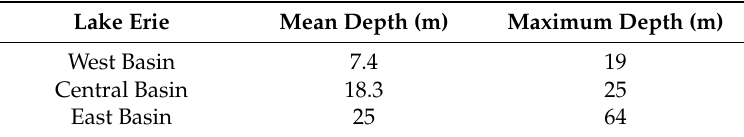
Figure 1. Location of Lake Erie and its boundary (Canada and US). In situ sampling stations from cruises that took place in September 2004, May, July, and September 2005, May and June 2008, July and September 2011, and February 2012 are illustrated by empty triangles. Table 1. Lake Erie Basins Information (source: [23]). Table 1. Lake Erie Basins Information (source: